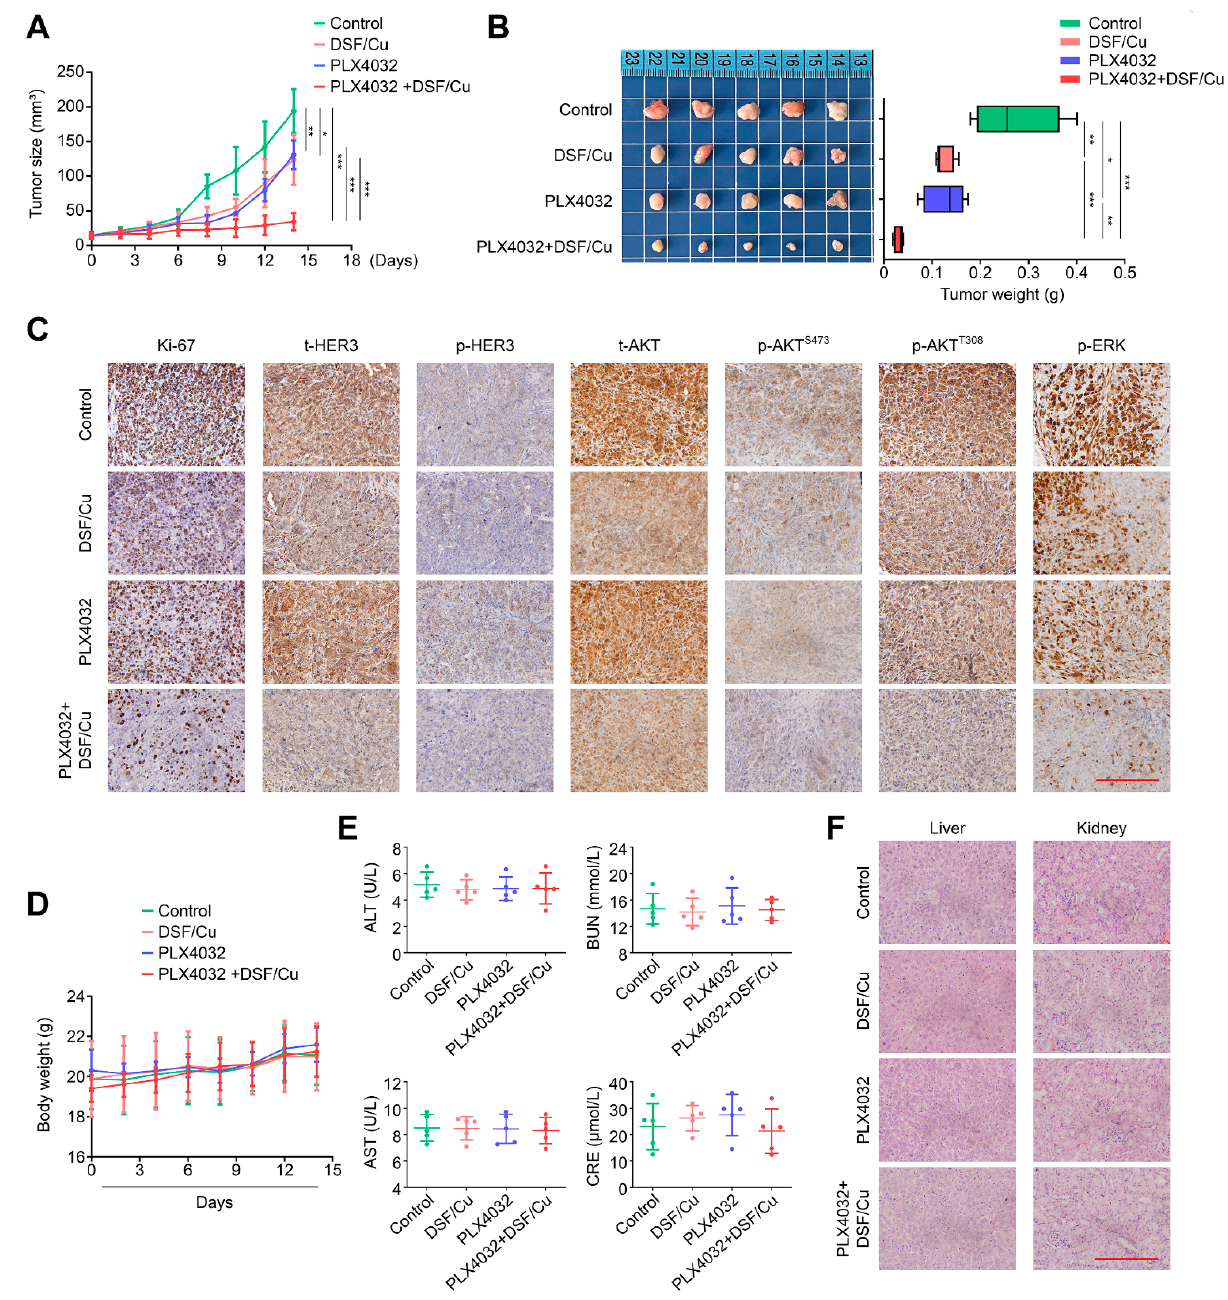
Figure 6. DSF/Cu exhibits a sensitizing effect on antitumor efficacy of PLX4032 in nude mice. A xenograft tumor model was established by subcutaneously injecting 8305C cells into the axilla of nude mice, and these mice were then randomly grouped and treated with DSF/Cu (DSF: 50 mg/kg; CuCl 2 : 0.15 mg/kg) and PLX4032 (50 mg/kg) alone or in combination, once a day. ( A ) Growth curves of xenograft tumors were drawn in each group. ( B ) Left and right panels show the pictures of dissected tumors and statistical results of tumor weight from the indicated groups. ( C ) IHC staining of Ki-67, t- HER3 , p- HER3 , t-AKT, p-AKT S473 , p-AKT T308 and p-ERK in tumor tissues from the indicated group. Scale bar: 200 µ m. ( D ) Growth cures of body weight were drawn in each group. ( E ) The levels of alanine transaminase (ALT), aspartate aminotransferase (AST), serum creatinine (CRE) and blood urea nitrogen (BUN) were measured by ELISA assay. ( F ) Representative H&E-stained slices of kidney and liver sections from the indicated mice. Scale bar: 200 µ m. Data presented as means ± SD. * p < 0.05; ** p < 0.01; *** p < 0.001.